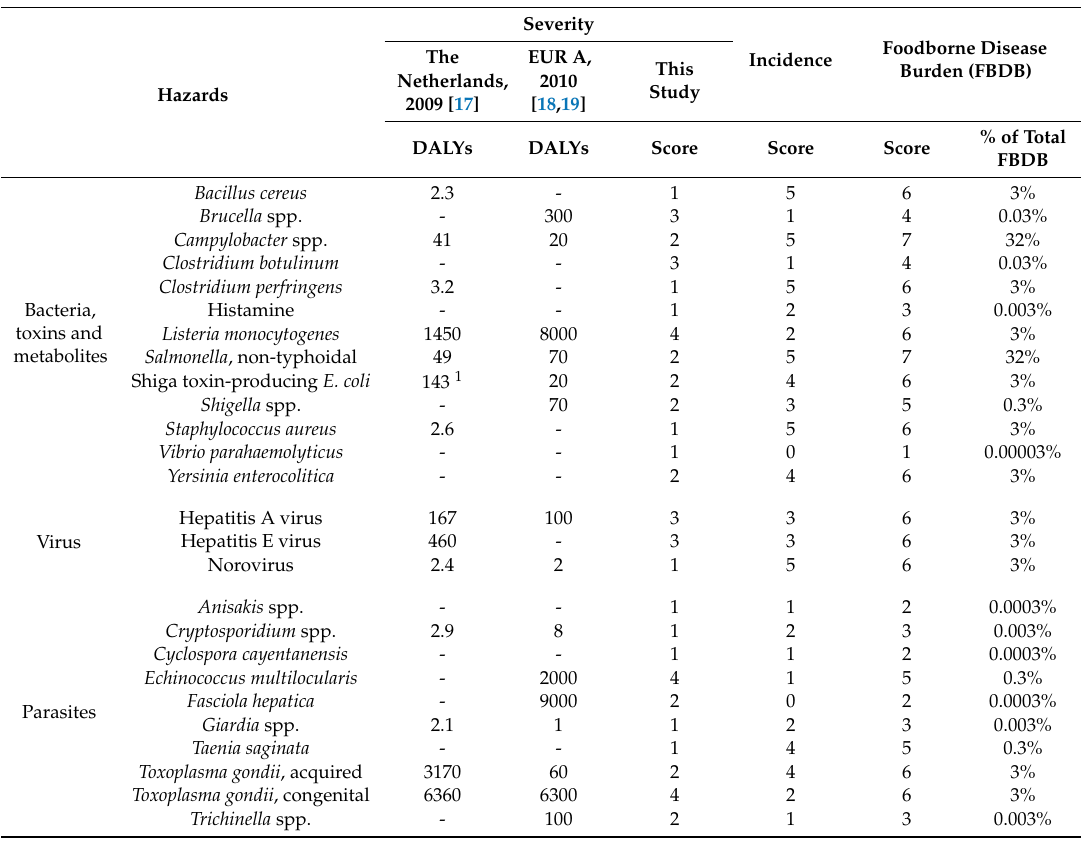
Table 2. Severity scores of foodborne illnesses (based on median foodborne disability-adjusted